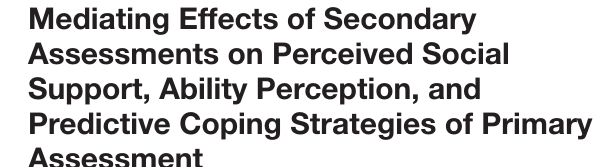
(1) The results from the absolute fit test: the absolute fit indexes X 2 /df of models 4 and 5 were 1.36 and 1.52, respectively. The corresponding probabilities P were 0.26 and 0.16,